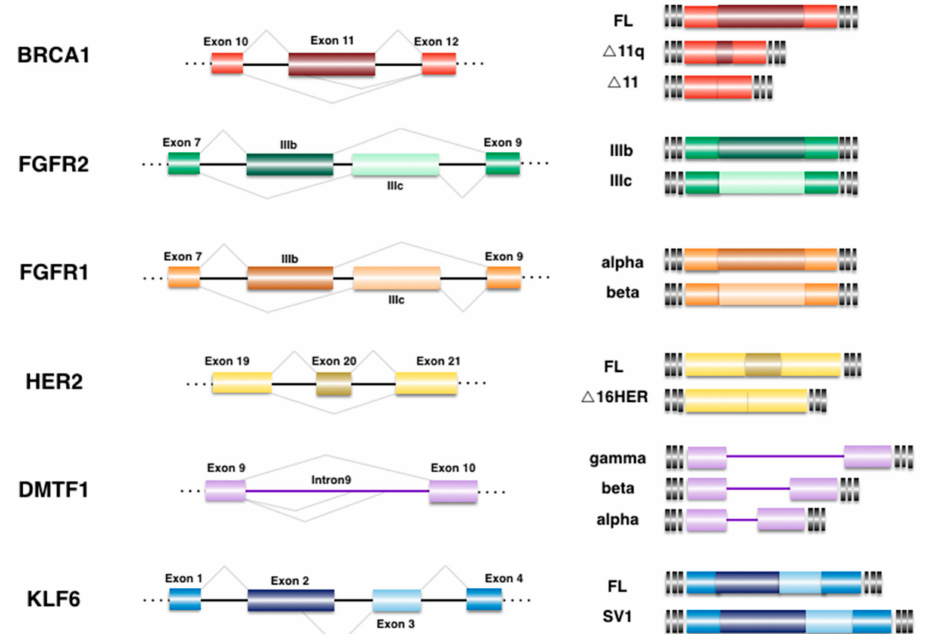
Figure 1. Alternative splicing events implicated in breast cancer (BrCa). Differential expression of various isoforms has been related to BrCa biology and tumorigenesis. The schematic representation of the pre-mRNA region that undergoes alternative splicing is illustrated at the left. The final outcome after alternative events is shown at right. Exons are depicted as boxes while introns are drawn as lines, alternative regions correspond to darker boxes, not drawn to scale. FL: full length